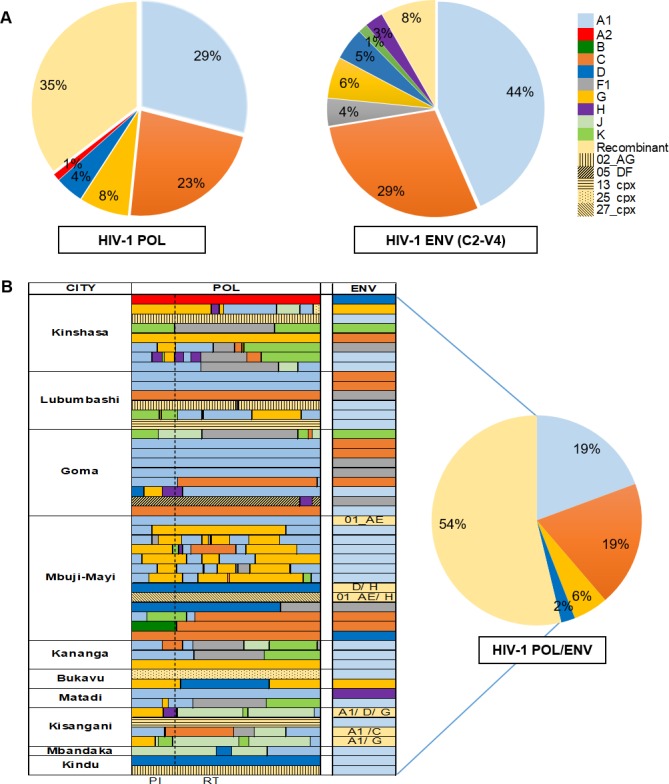
The overall HIV-1 genetic diversity and circulating recombinants observed in ten cities.(A) The proportion of HIV-1 subtypes based on the pol and env sequences, respectively. The different clades are color coded as shown. (B) Representation of the mosaic structure in the pol genes (HXB2 2133–3445 nt) by Simplot without bootstrap threshold. The approximate breakpoints between subtypes were analyzed by bootscanning analysis of pol genes with the following conditions: window: 400bp; step: 40bp; gap-strip: on; T/t: 2.0; Neighbor-Joining; Kimura (2-parameter); 100 bootstrap replication. The proportion of HIV-1 subtypes in each of the ten cities based on the paired sequences of pol and env. The different clades are color coded as shown and the types of recombinant as determined by the pol and env sequences are as indicated. Structures of recombinants were determined by parallel comparison of HIV-1 strains between pol and env. For subtyping, REGA V3 subtyping tool and jpHMM were utilized.